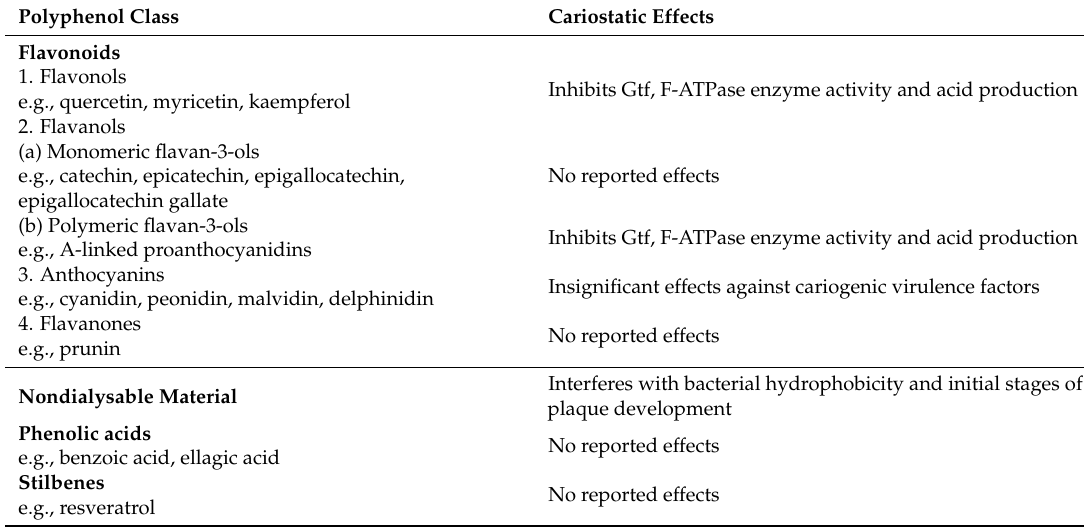
Table 1. Cranberry polyphenols and their cariostatic